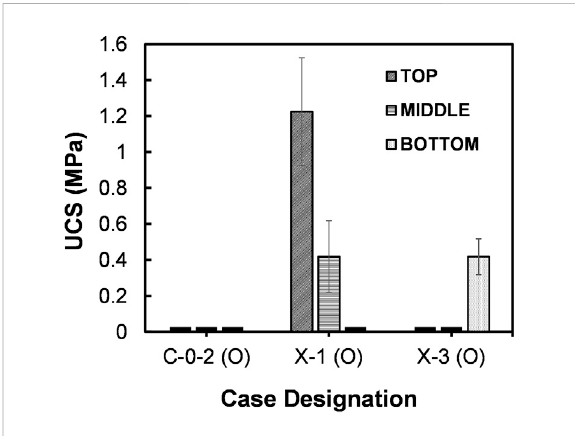
FIGURE 5 Comparison of UCS between MICP and B-EICP samples of fi ne sand – Onuma soil (where the case X-1 (O) is MICP, X-3 (O) is B-EICP and C-0-2 (O) is the control).